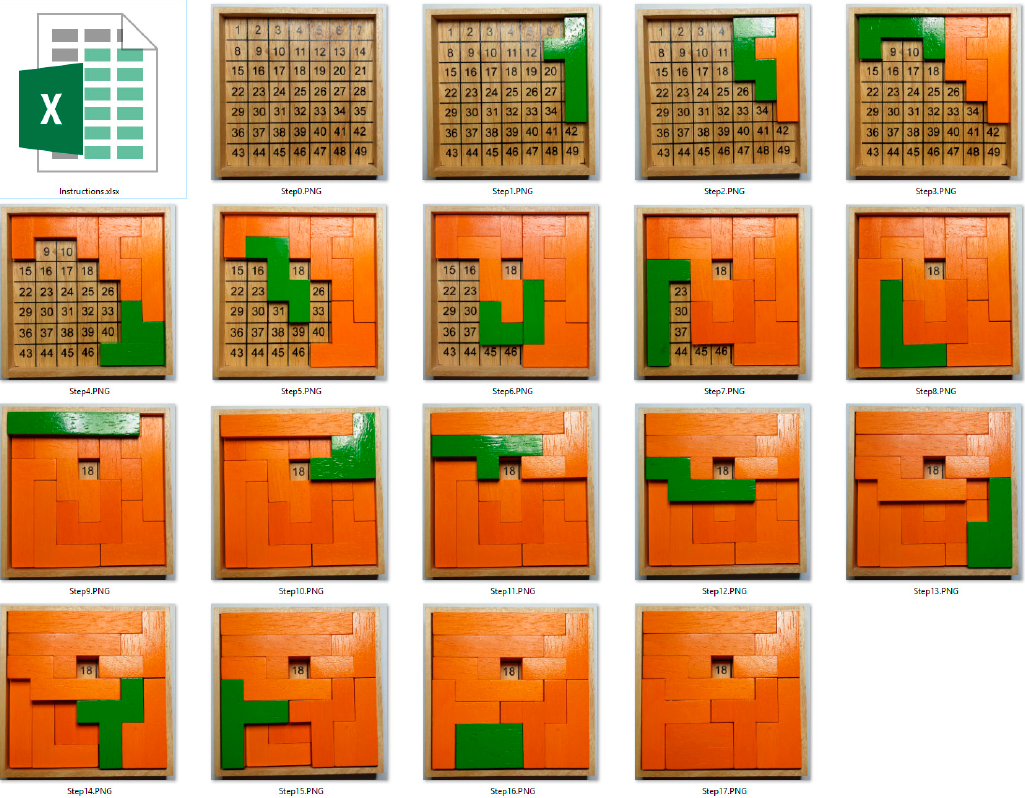
Figure 11. Gillux-Puzzle assembly steps (for solution field 18).